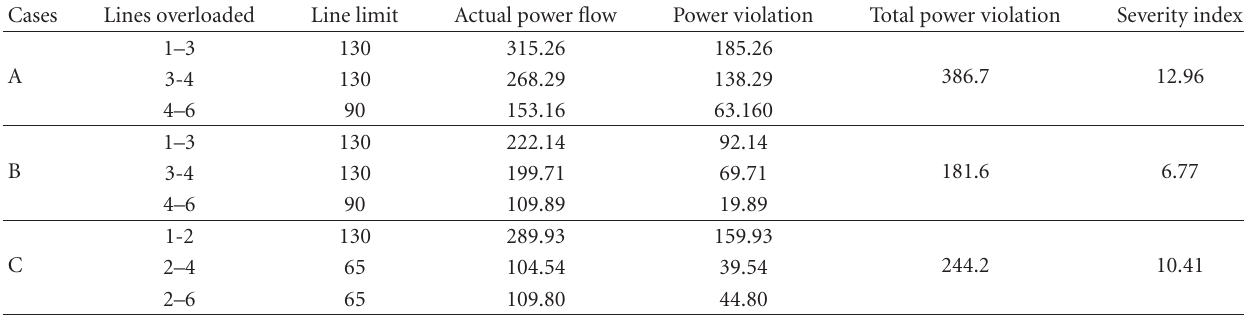
Table 2: Simulated case for IEEE 30 bus system.